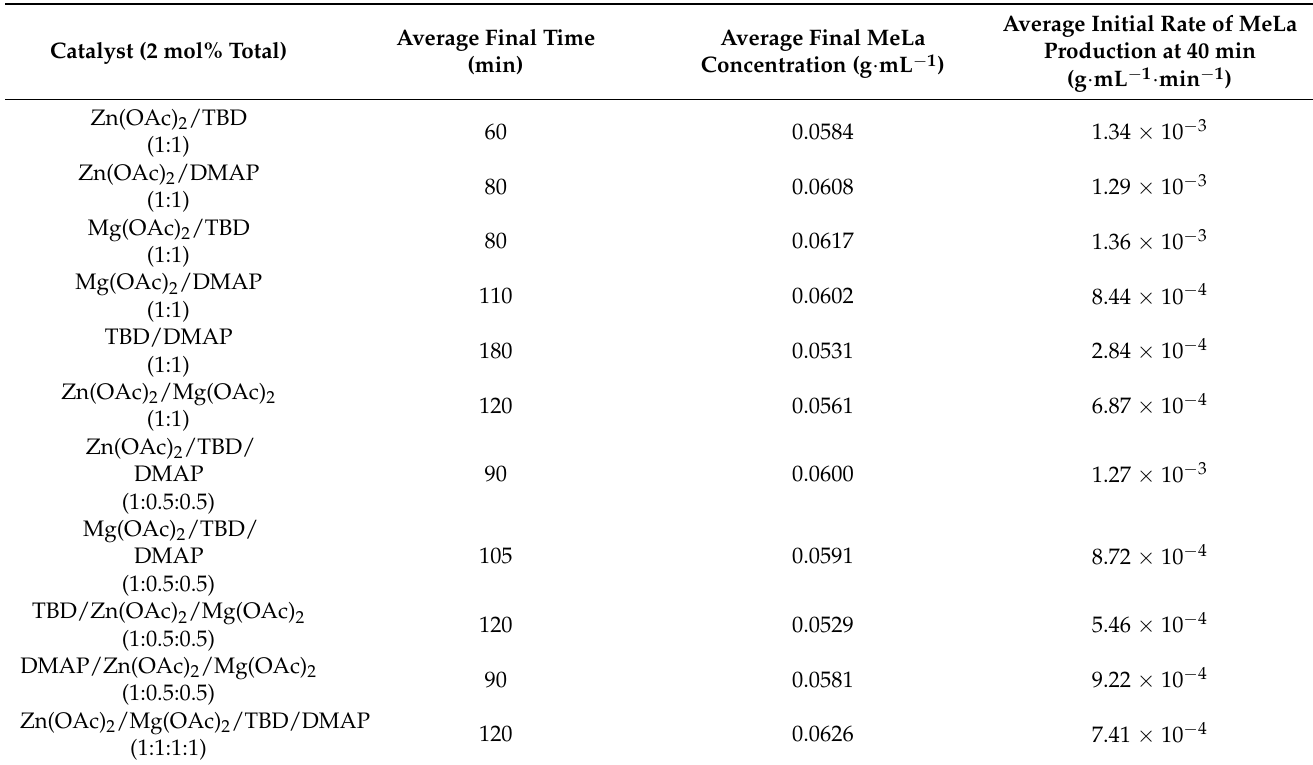
Table 2. Methanolysis of 2 g PLA at 130 ◦ C, 600 rpm, 2 mol% catalyst total and 17 eq MeOH. Repeat (2–4 repeats) were